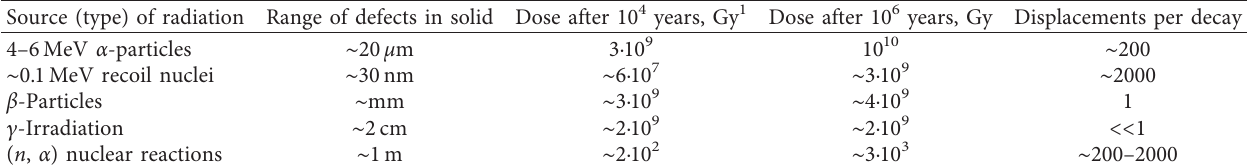
Table 2: Self-irradiation types in HLW borosilicate glass matrices, after [4, 6, 17].